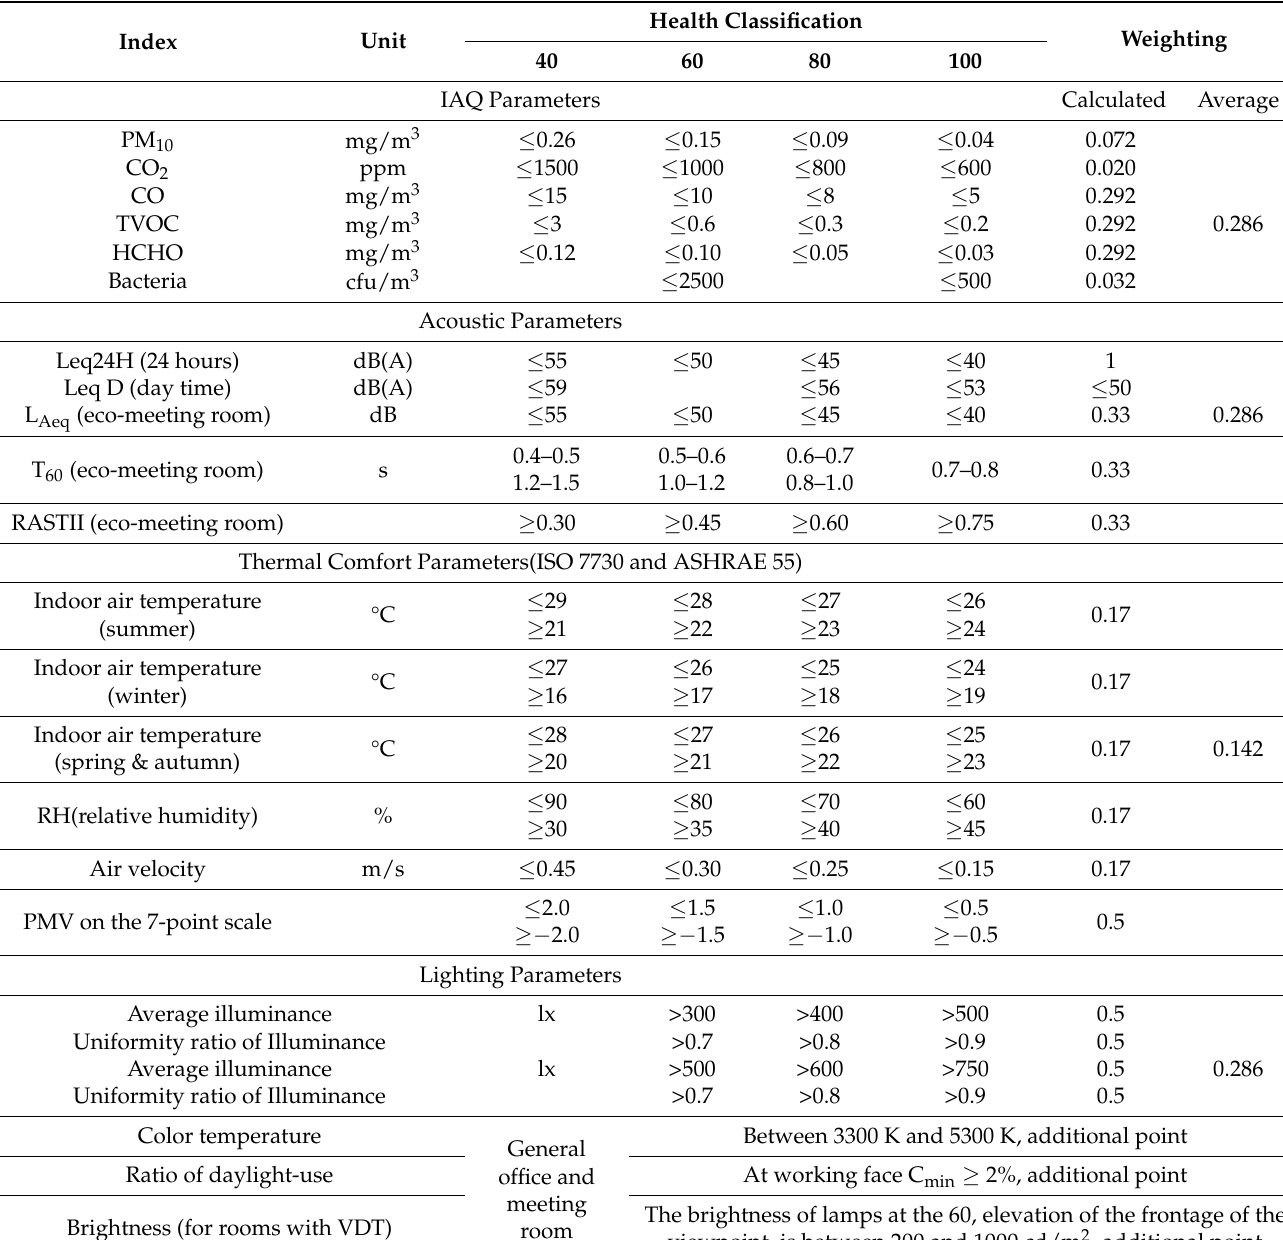
Table 2. Various environmental health assessment index classifications and weighting.